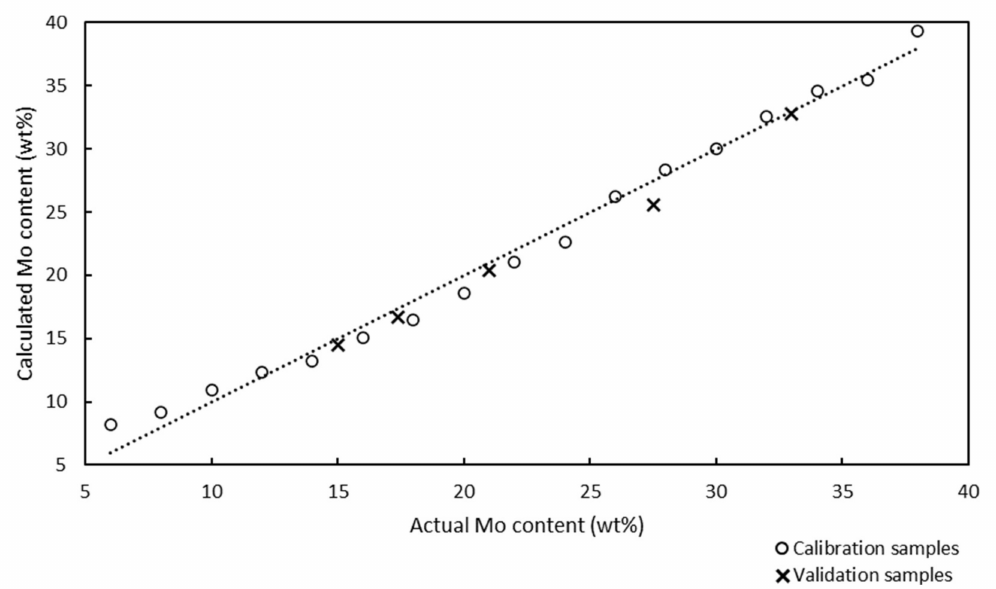
Figure 2. Raman model for the quantitative analysis of Mo-supported mesoporous silica catalysts with Mo contents in the range of 6–38 wt%. Correlation coe ffi cient: 0.9943, one factor used. The circles and × marks represent the calcinated calibration and validation samples, respectively. Electronic supplementary material, Table